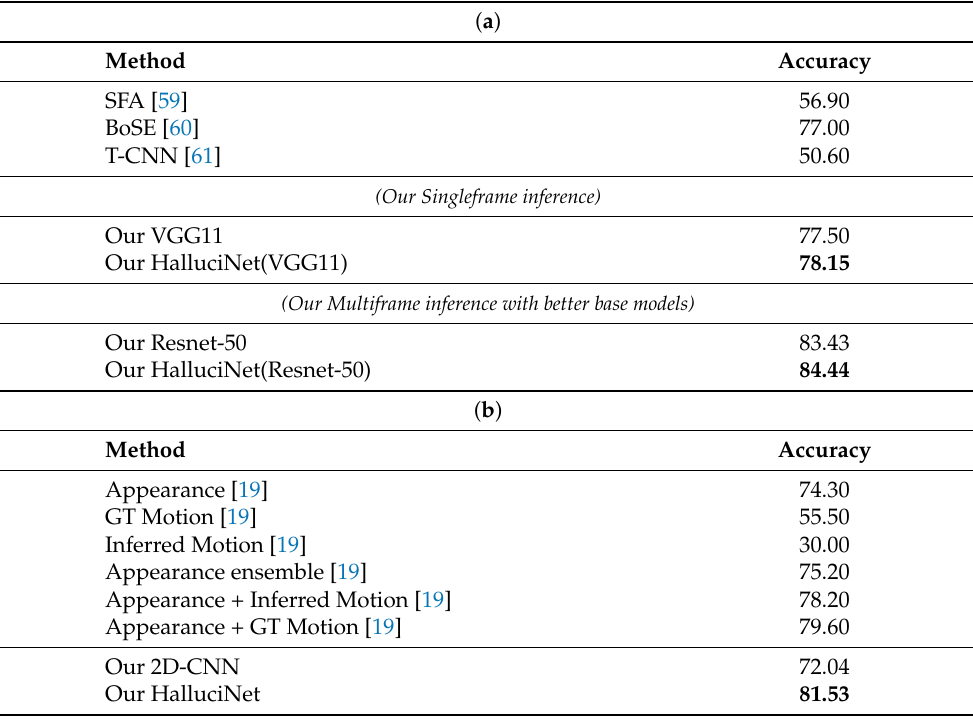
Table 4. ( a ) Dynamic scene recognition on YUP++. ( b ) Dynamic scene recognition on